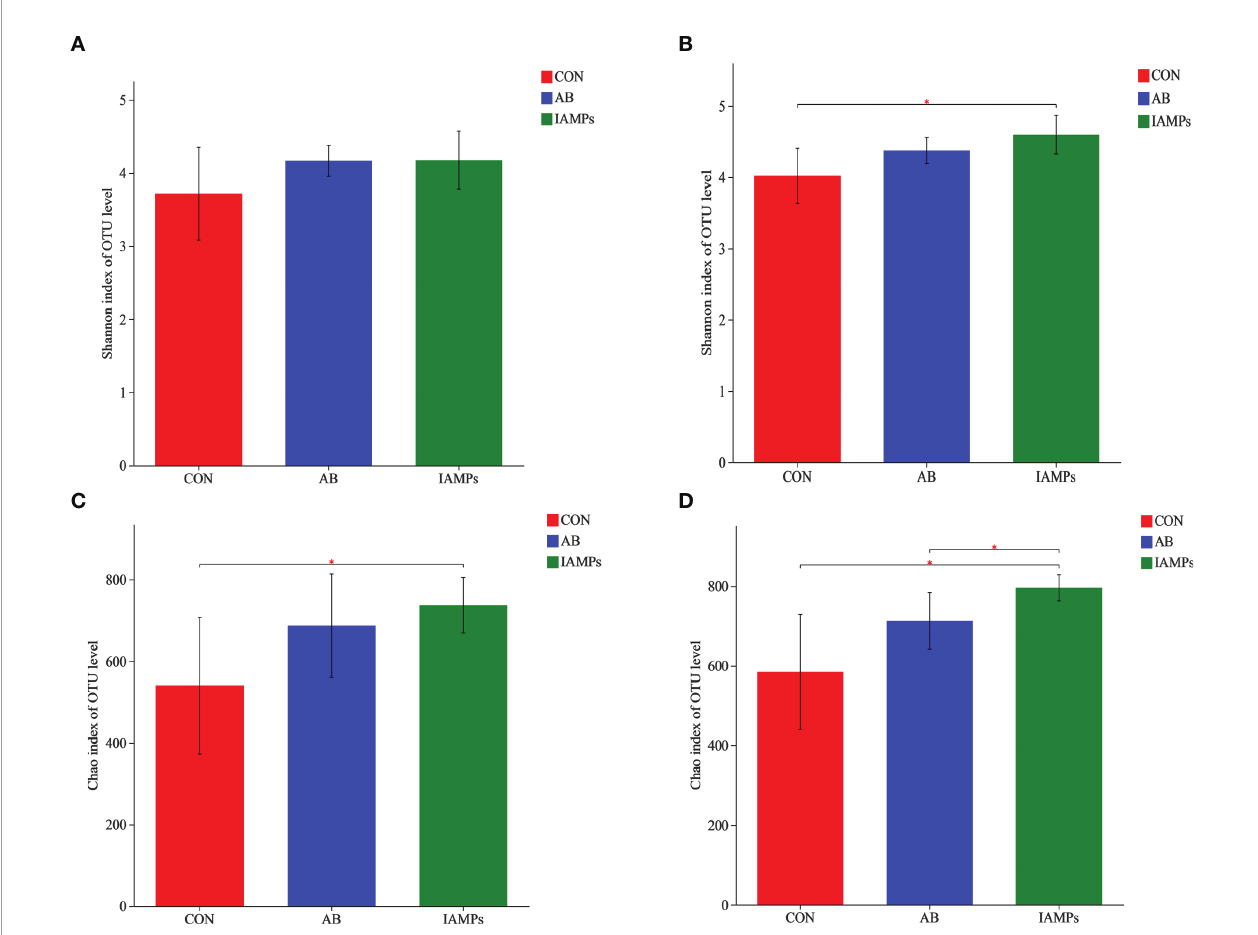
FIGURE 3 | Effect of IAMPs on alpha-diversity index of cecal and colonic digesta of weaning piglets. (A) Cecal Shannon index; (B) cecal Chao index; (C) colonic Shannon index; (D) colonic chao index. The individual pig was regarded as the experimental unit (n = 5). CON, corn – soybean meal-based diet; AB, CON + 25 mg/